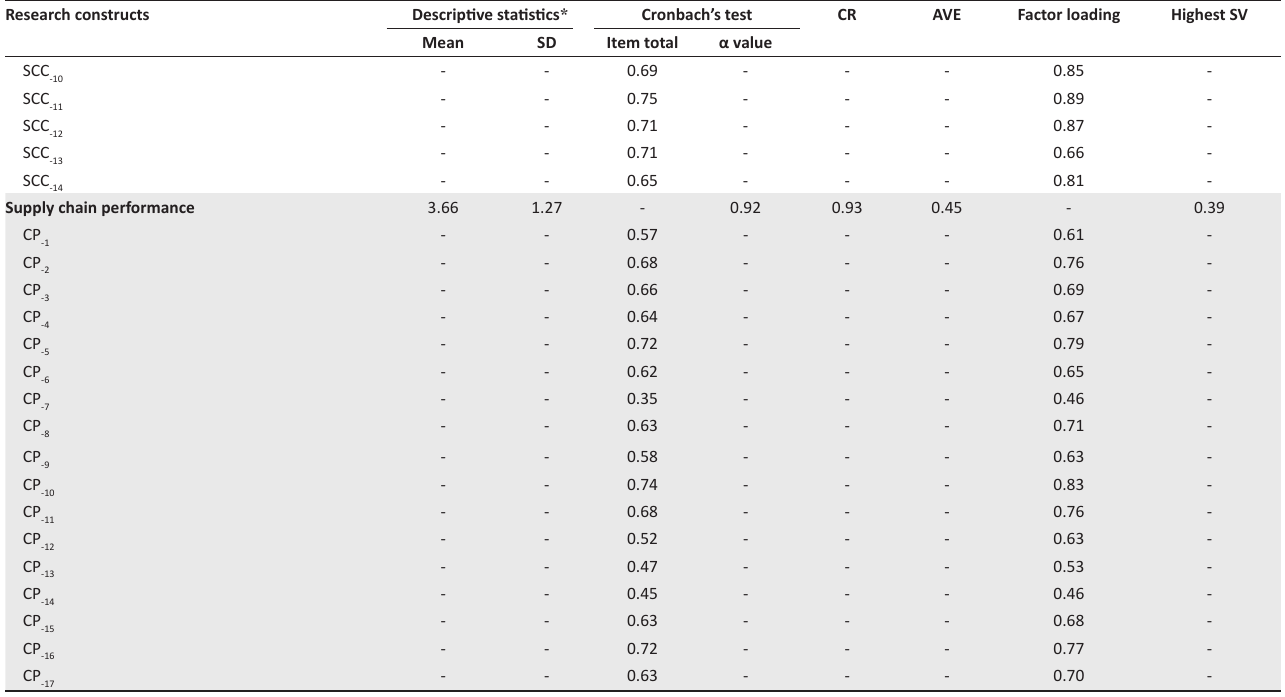
TABLE 2 (Continues): Accuracy analysis statistics: Reliability